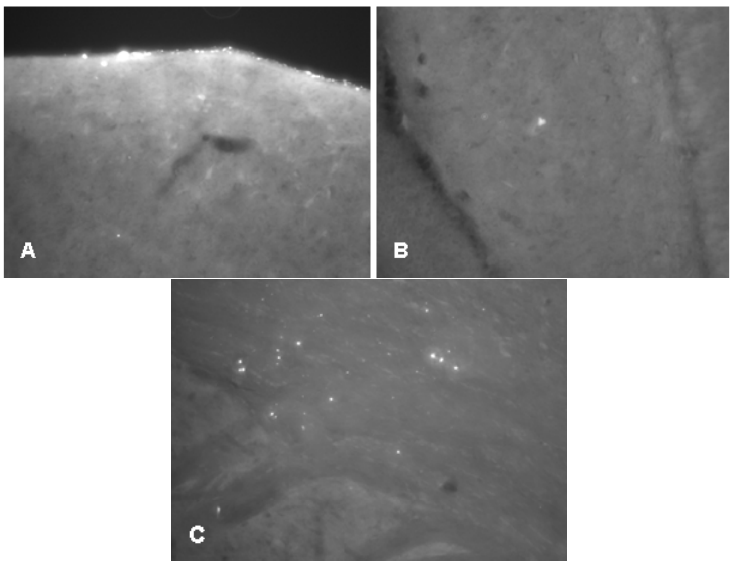
Figure 2. Oligomeric A β 1-42 enters the brain parenchyma. Representative examples of brain sections after icv injected AMCA-labelled A β 1-42 oligomers. ( A ): diffusion from the vehicle (5 min after injection) ( B ): signal in hippocampus (5 min after injection); ( C ): signals in brain parenchyma (60 min after injection). Animals were injected unilaterally with 7.5 μ L solution, the surgical procedure was the same as described in Materials and Methods.